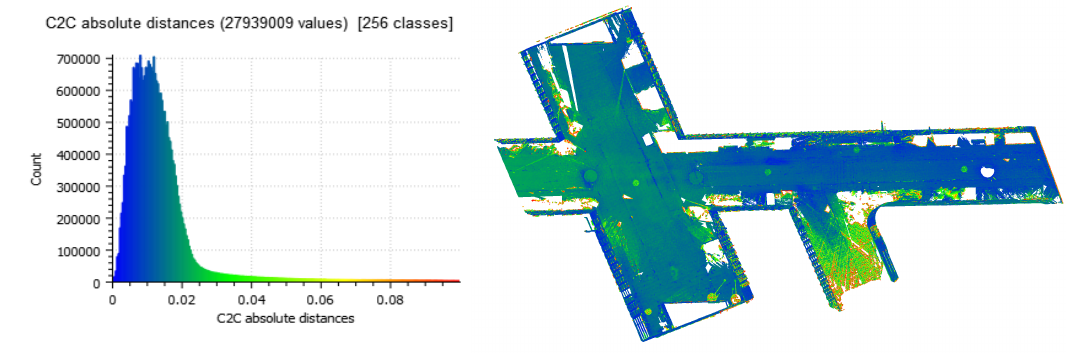
Figure 8. Residuals from the Cloud2Cloud comparison of the expert’s point cloud and ours: Histogram (left), point cloud